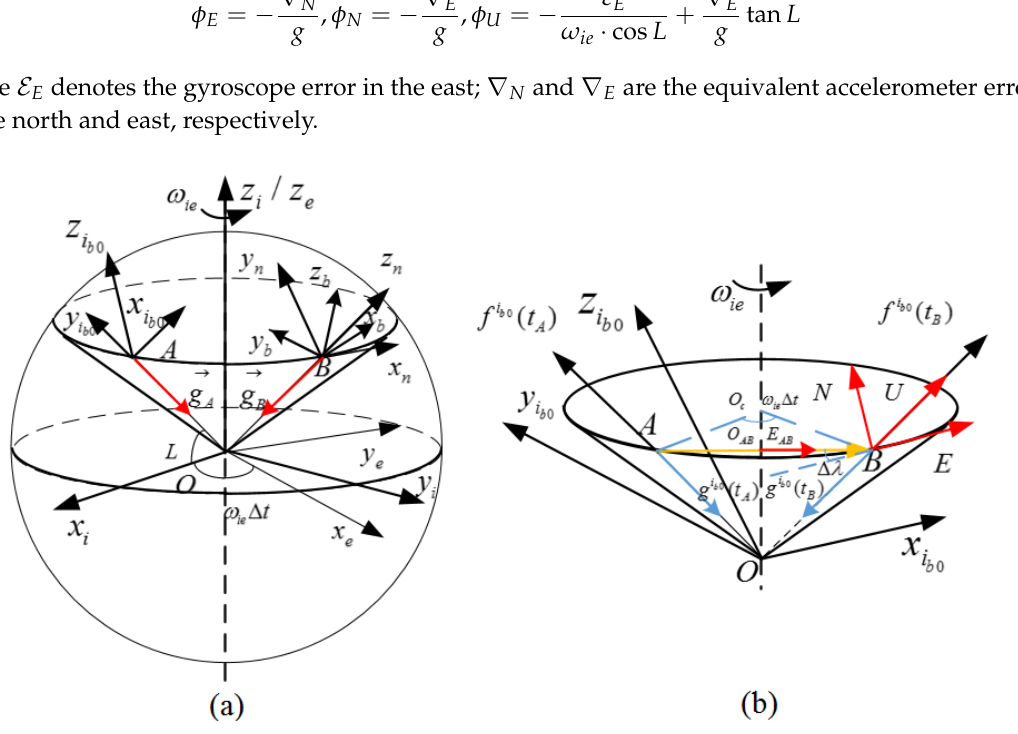
Figure 1. Apparent motion of the gravity vector in the inertial frame: ( a ) The trajectory of the gravity vector; ( b ) Alignment process based on GAM.